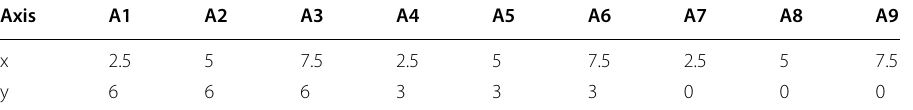
Table 1 Coordinates of sensors (Ahmadnejad Zarnaghi and Tarighat 2018)